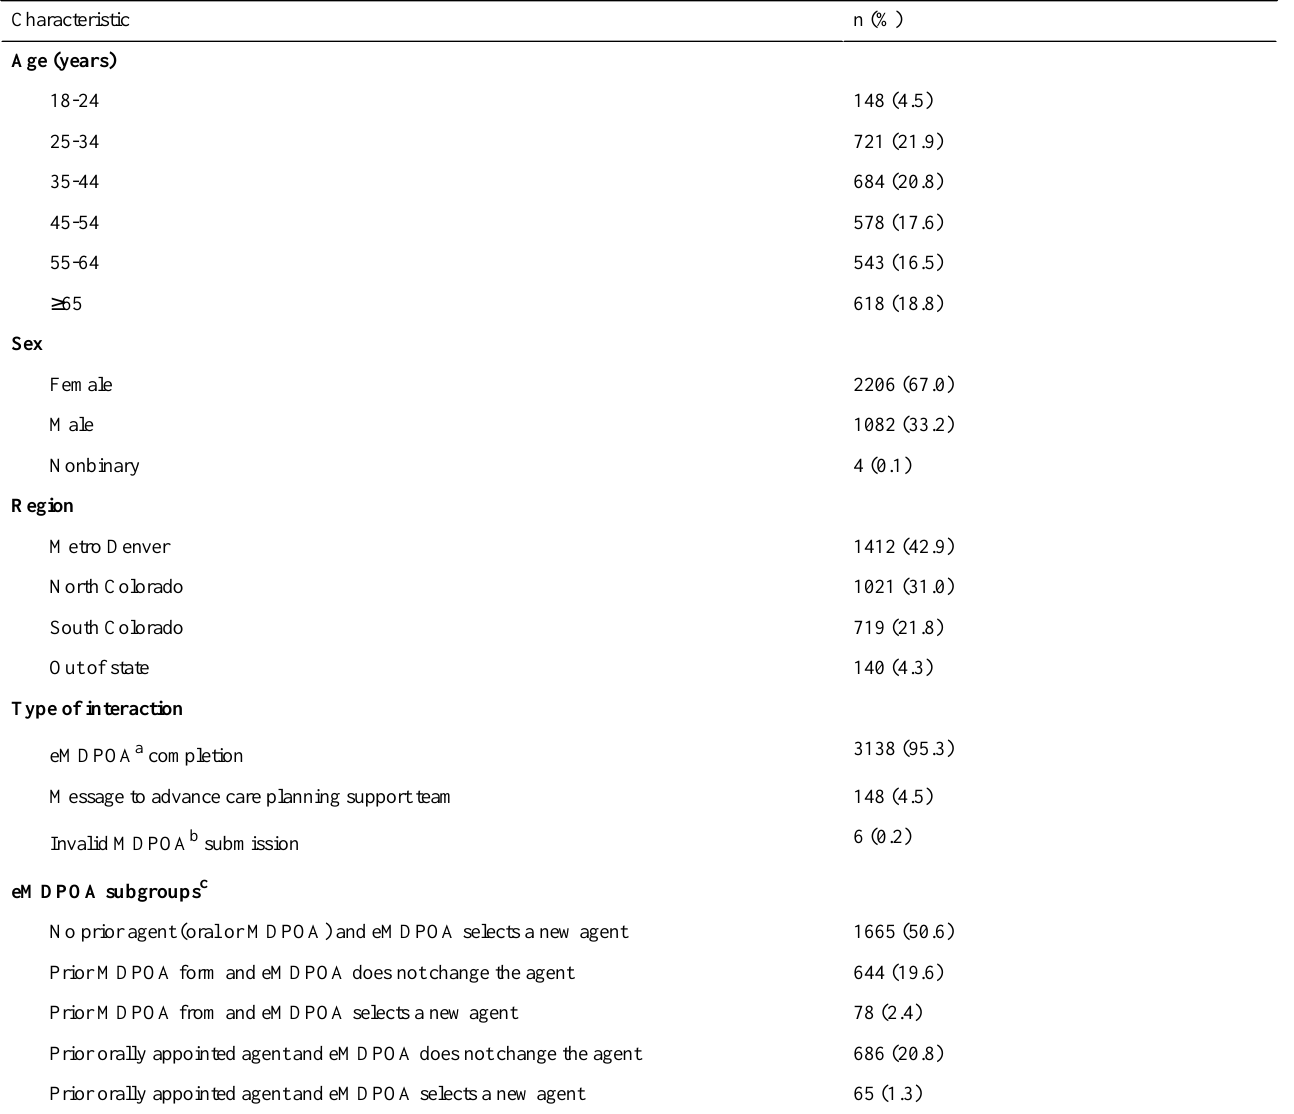
Table 1. Characteristics of patient portal users from December 29, 2019 to May 30, 2020 (N=3292).